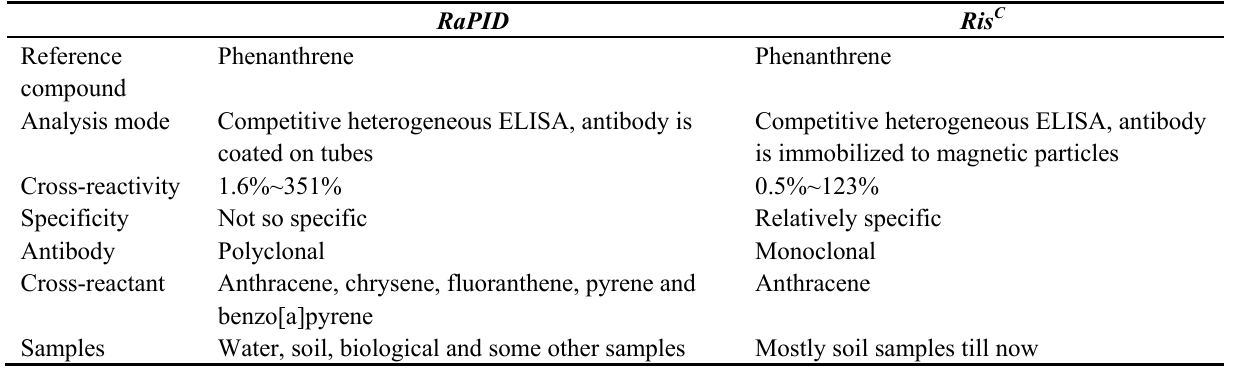
Table 4. Comparison of the Two PAHs ELISA